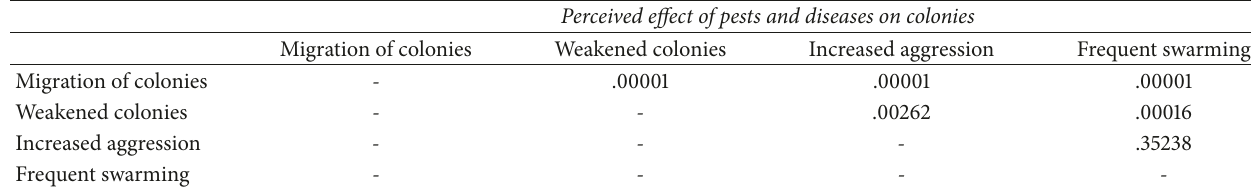
Table 7: P-value matrix for cross tabulation of perceived effect of pests and diseases.